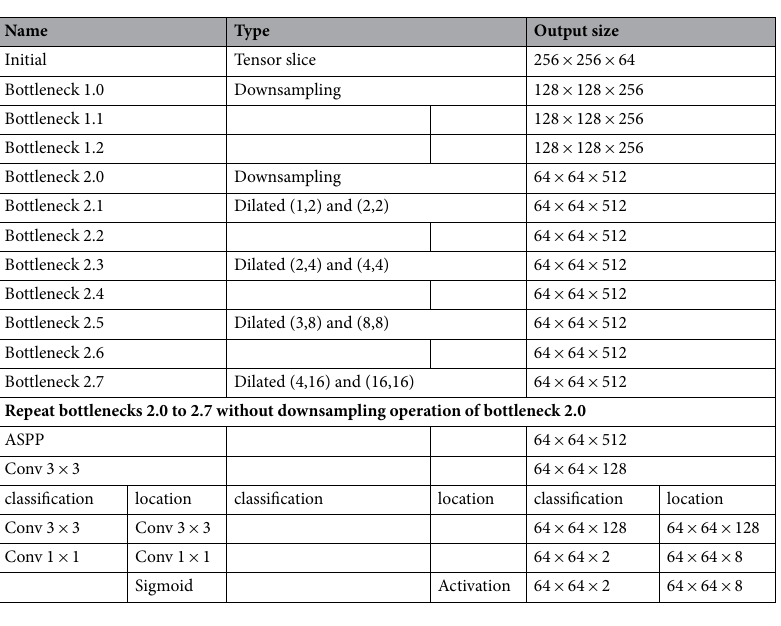
Table 1. StairNet architecture. The bottlenecks with downsampling have a stride = 2 in the 3 × 3 convolution and the bottlenecks without downsampling have a stride = 1 in the 3 × 3 convolution.